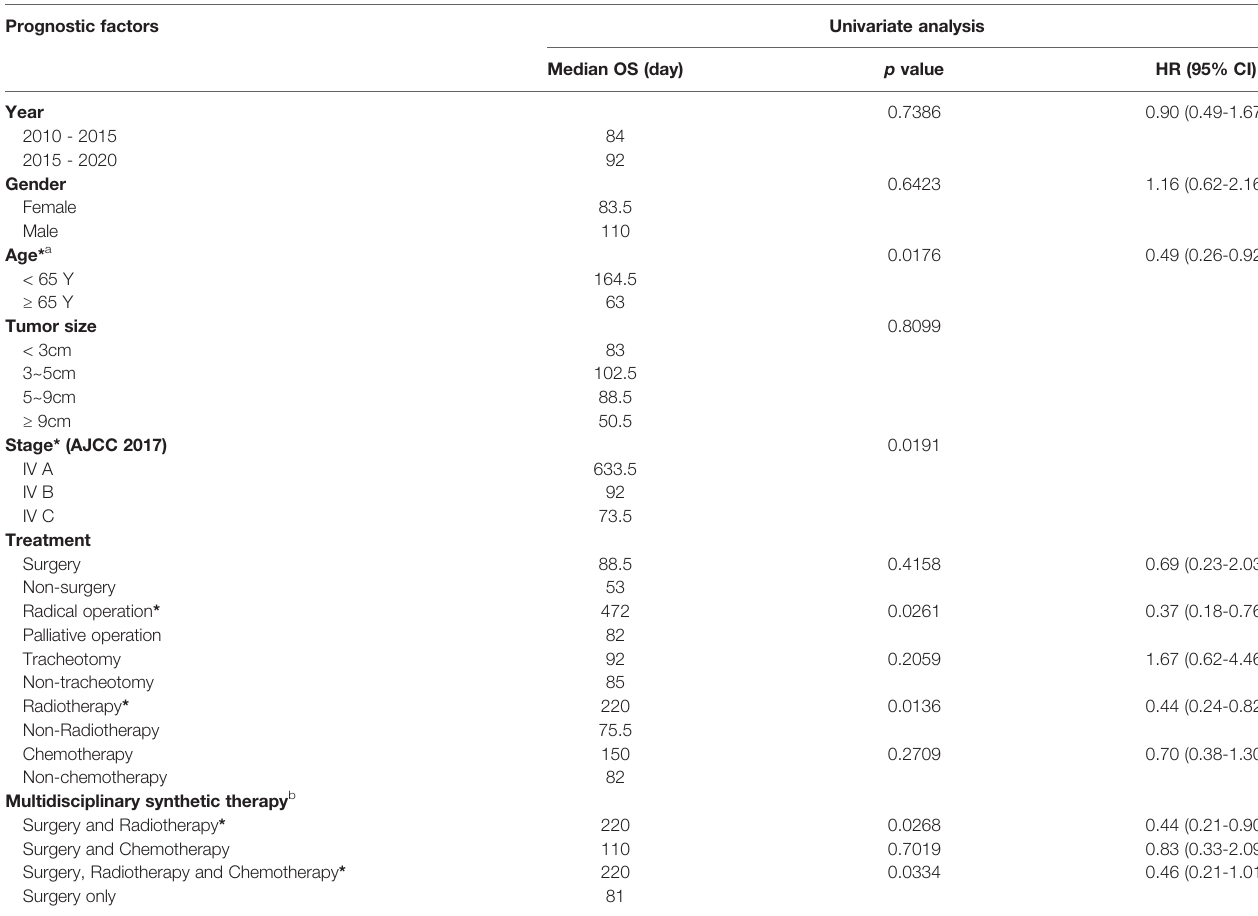
TABLE 3 | Multivariate analysis of survival